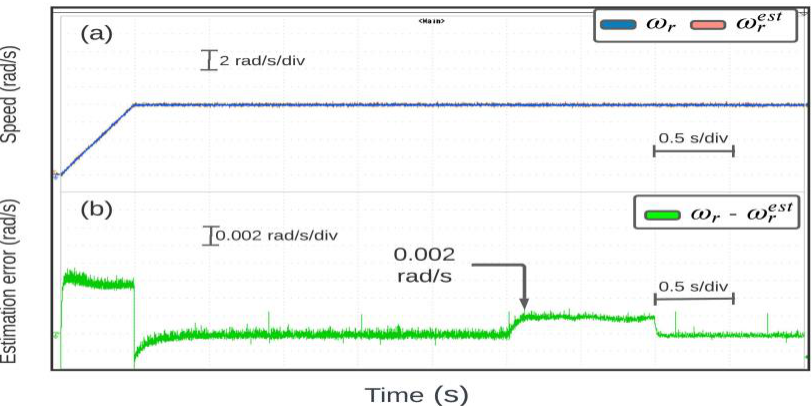
Figure 17. OeW-5PIM performance under rotor parameter changes ( a ) speeds responses; ( b ) estimation error.